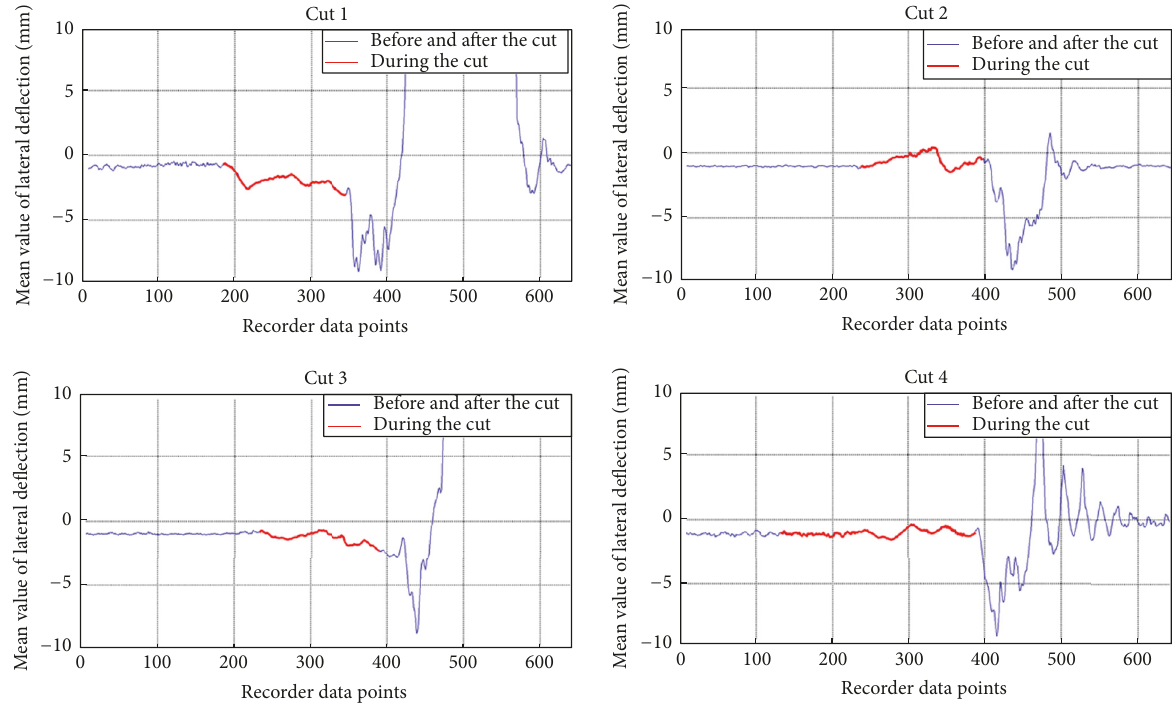
Figure 18: Experimental cutting results, cut at 1800 rpm.